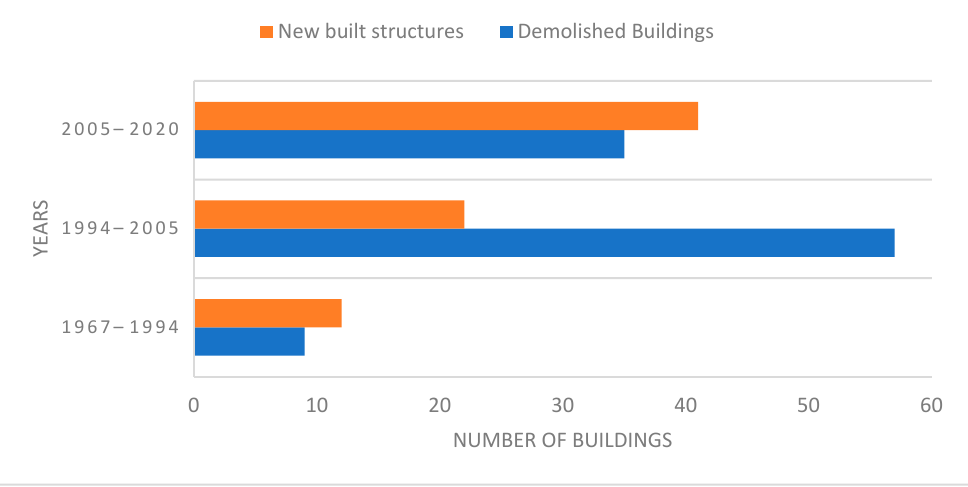
Table 1. Summary of demolitions and new buildings (1967–2020).